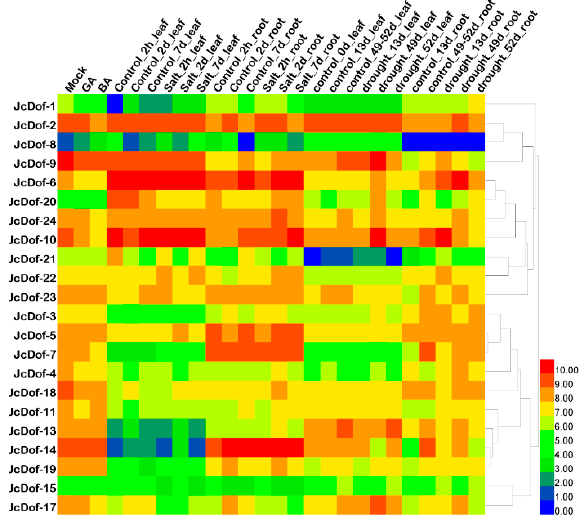
Figure 6. Expression patterns of JcDof genes under different treatments. The heatmap was generated by HemI software using the expression data of the JcDof genes, and normalized log 2 transformed values were used with hierarchical clustering represented by the color scale (0–10). Blue indicates low expression, and red indicates high expression. The samples were: roots and leaves (salt- and drought-stressed at different times), and roots (BA treatment). The detailed information of expression data are described in Supplementary Tables S6 and S7.